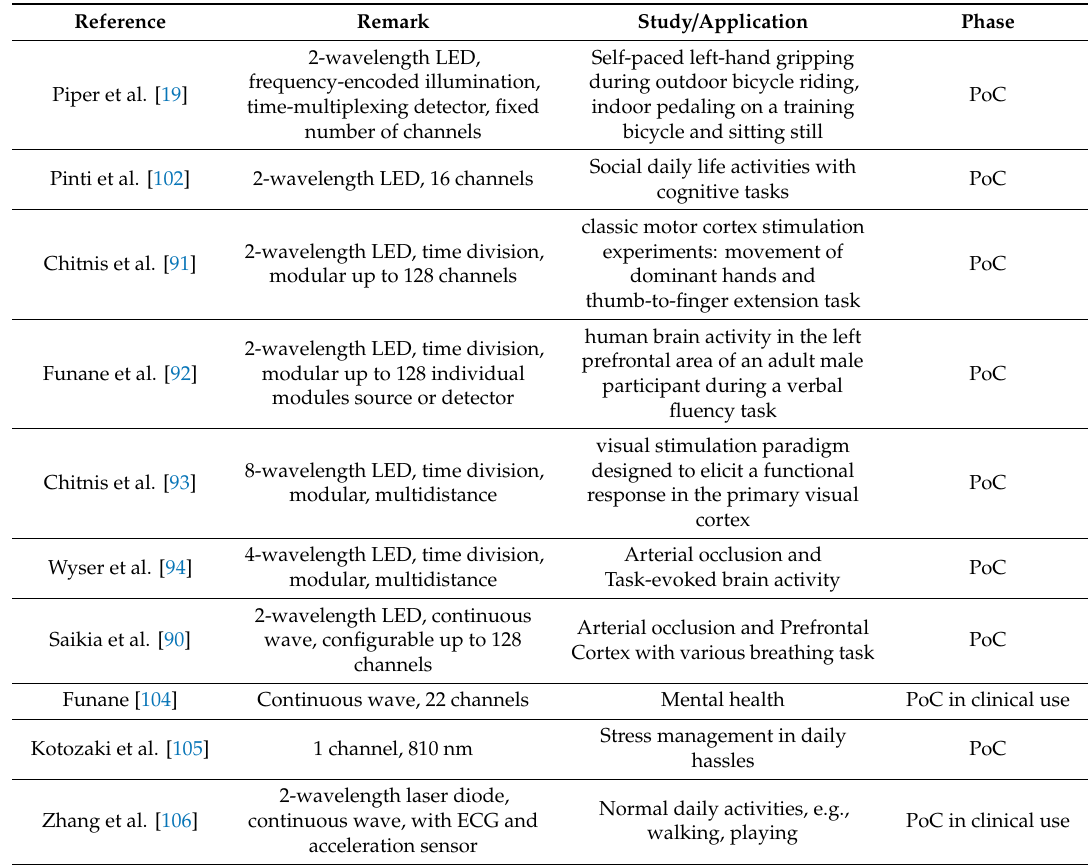
Table 2. List of selected wearable fNIRS